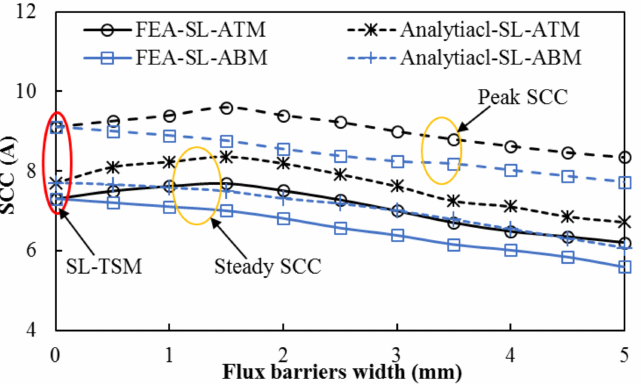
Figure 8. Variation of the peak SCC and the steady SCC with the width of flux barriers at 1000 r/min.